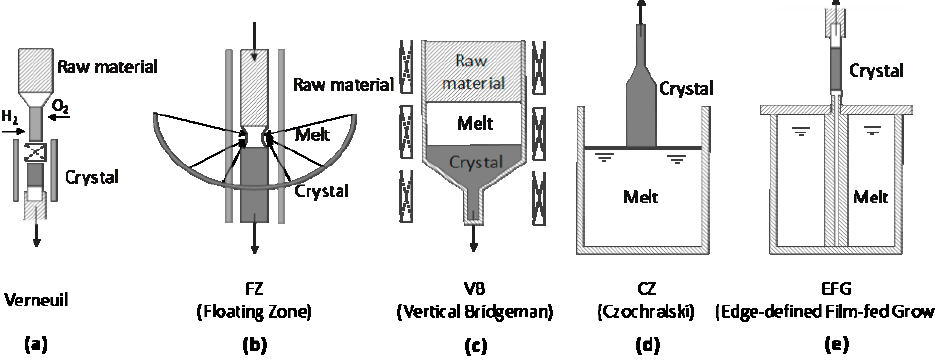
Figure 2. Schematic illustrations of melt growth of β -Ga 2 O 3 : ( a ) Verneuil method; ( b ) floating zone method; ( c ) vertical Bridgeman method; ( d ) Czochralski method; ( e ) edge-defined film-fed growth method.